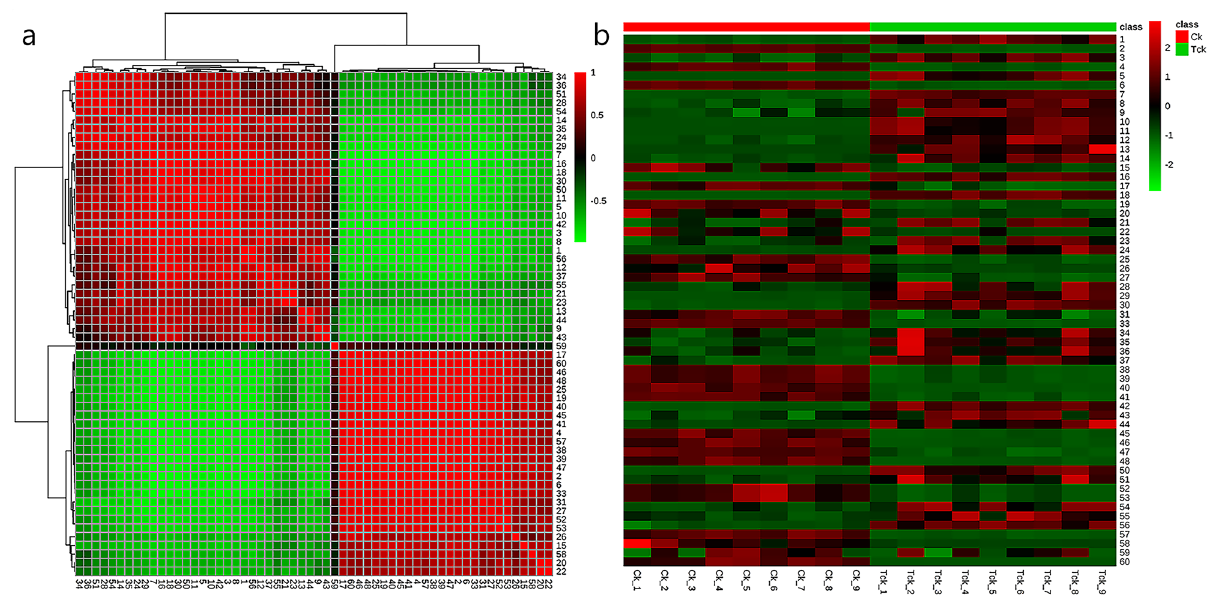
Figure 3. The hierarchical clustering heatmap visualizing the changes in the contents of potential metabolites in T. controversa -infected and noninfected samples by MetaboAnalyst 5.0 software (https:// www. metab oanal yst. ca/ faces/ Modul eView. xhtml). ( a ) Correlation analysis of differential metabolites. Deeper colors had stronger correlations, and lighter colors had weaker correlations. ( b ) Hierarchical cluster analysis of differential metabolites. Red indicates that the contents of the metabolites increased, and blue indicates that the content of the metabolites decreased. Metabolic